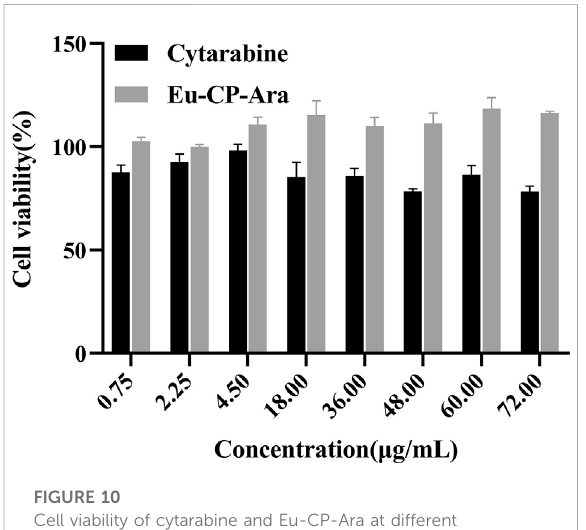
FIGURE 11 Cell viability of europium nitrate hexahydrate at different concentrations on L02 cells (0.75, 2.25, 4.5, 18, 36, 48, 60, and 72 μ g/ml).